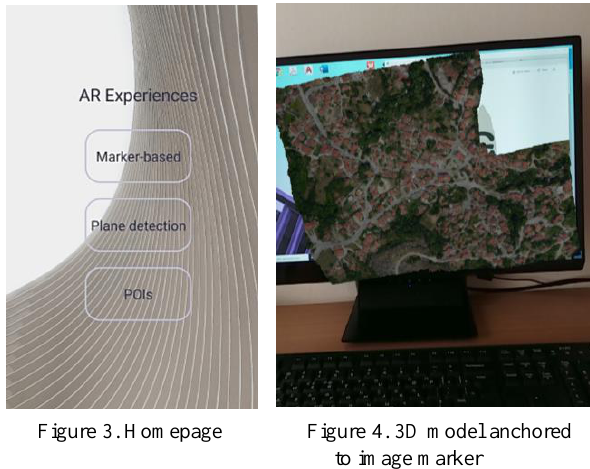
Figure 3. Homepage Figure 4. 3D model anchored to image